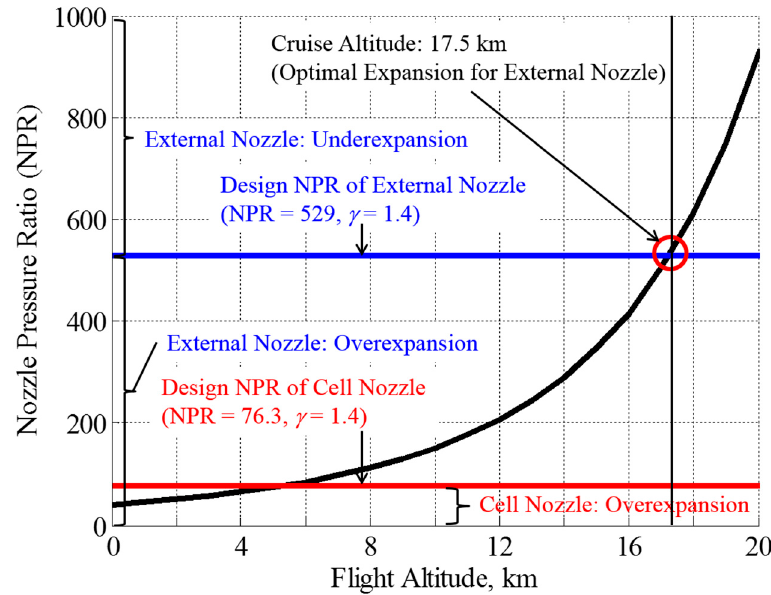
Figure 2. Simulated flight conditions and nozzle expansion conditions.